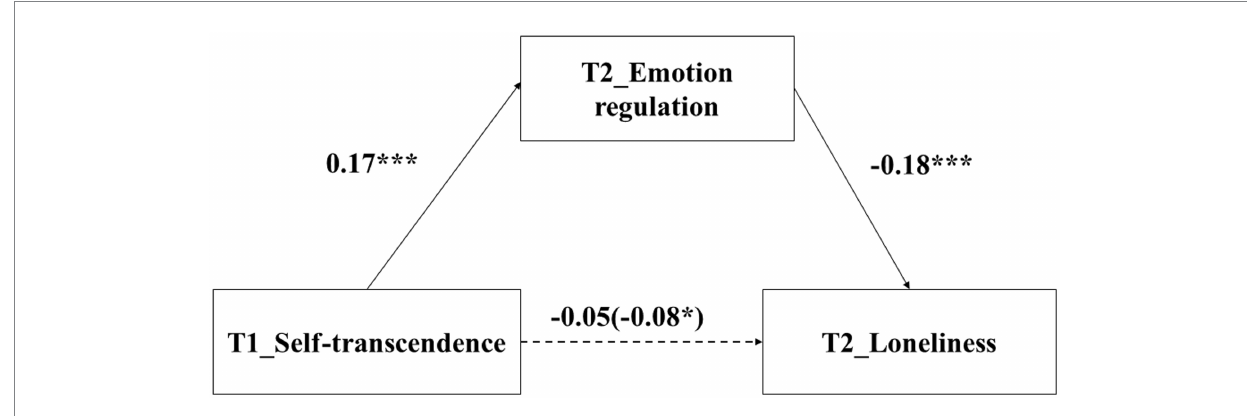
FIGURE 2 The mediating effect of emotion regulation. * p < 0.05, *** p < 0.001.